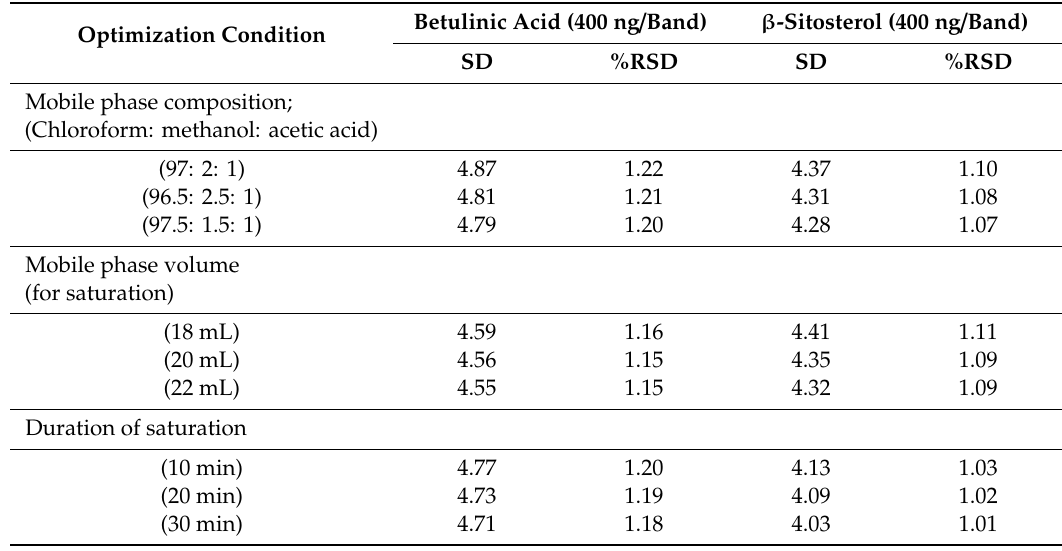
Table 6. Robustness of the proposed HPTLC method (n =